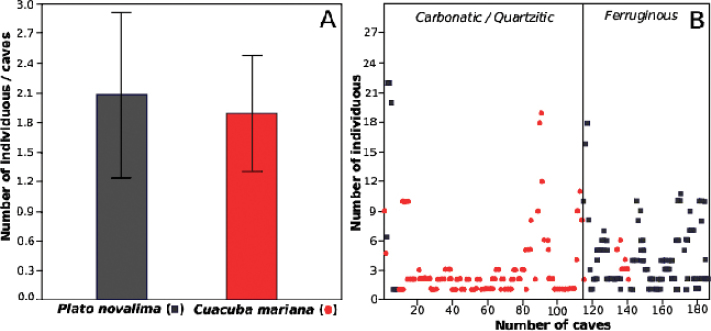

A Mean value of individuals collected per cave B Number of individuals collected per cave in their respective lithologies.